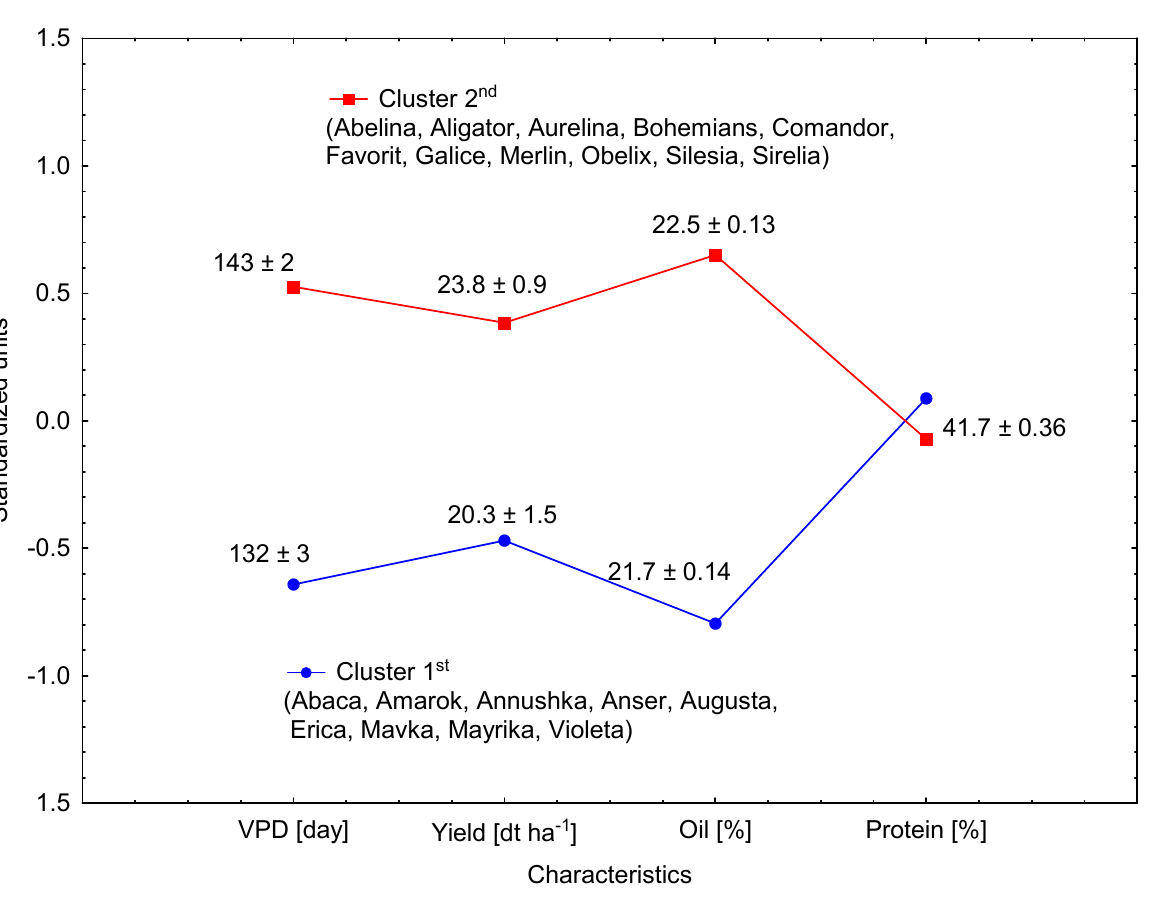
Figure 7. Two clusters of soybean cultivars separated on the basis of the k -means cluster analysis. Means ± standard errors from the locations and research years 2018–2020 in Central Poland. Table 8. Clusters of soybean cultivars in terms of vegetation period days, seed yield, oil content and protein content for tillage and no-tillage cultivation system. Means ± standard errors from the locations and research years 2018–2020 in Central